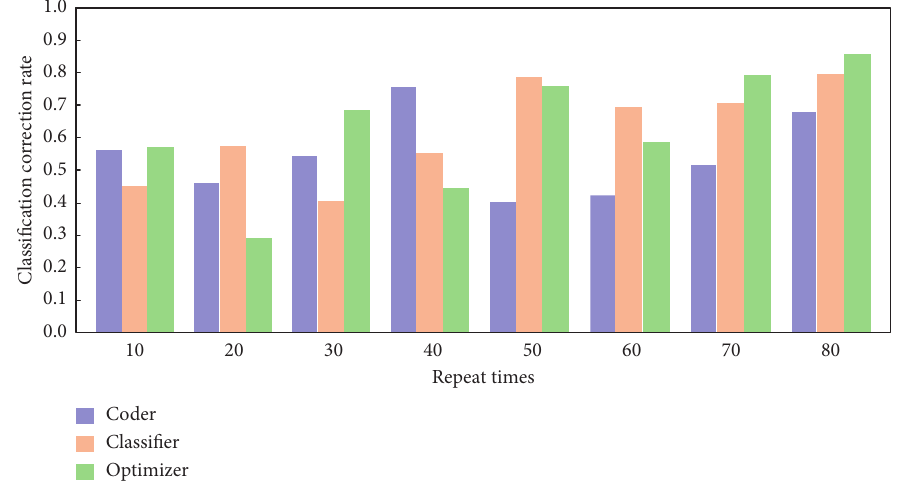
Figure 7: Relationship between classification correct rate and repeat times in coder, classifier, and